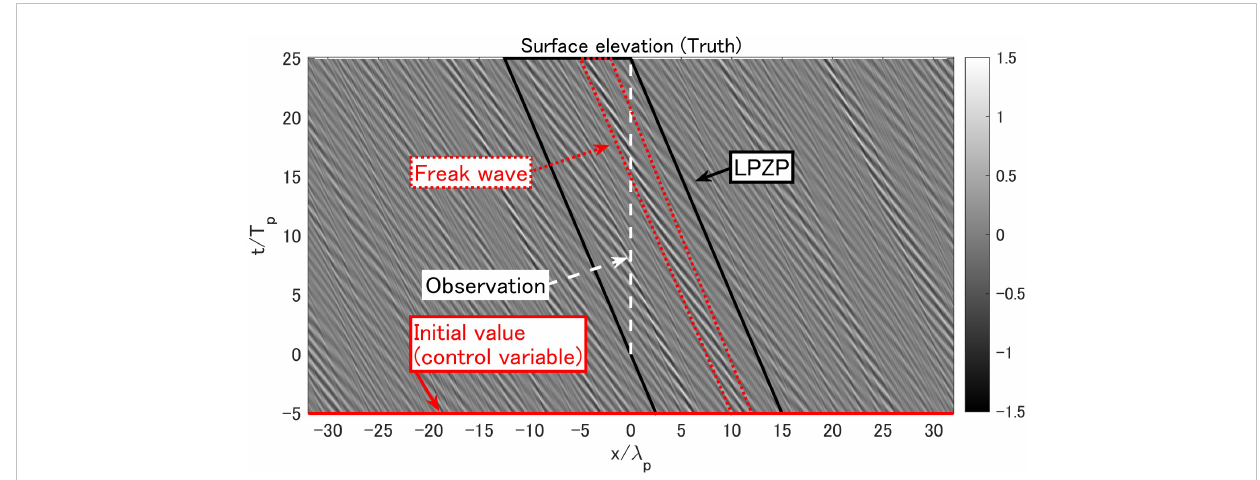
FIGURE 4 Generated truth (contours), measured points in the water level time series (dashed white lines), and linearly predictable zone corresponding peak wavelength (LPZP, solid black line). The wave groups, including the freak wave, are shown as red dotted lines. The initial value was taken as the control variable in the